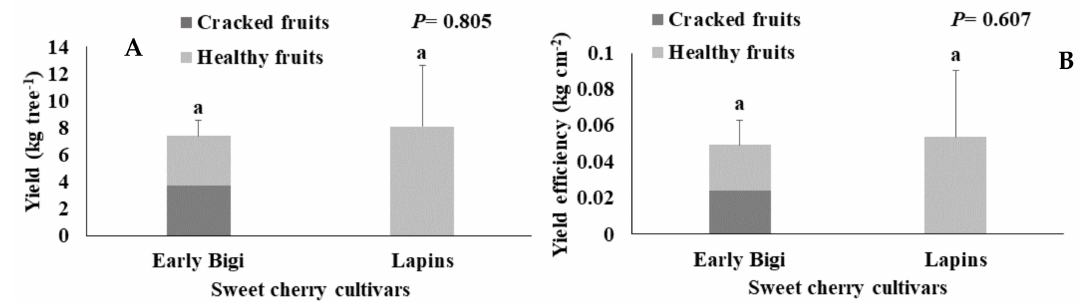
Figure 1. ( A ) Yield (kg tree − 1 ) and ( B ) yield e ffi ciency (kg cm − 2 ) of two sweet cherry cultivars (Early Bigi. and Lapins). Data are expressed as mean ± standard deviation. Similar letters indicate no statistically